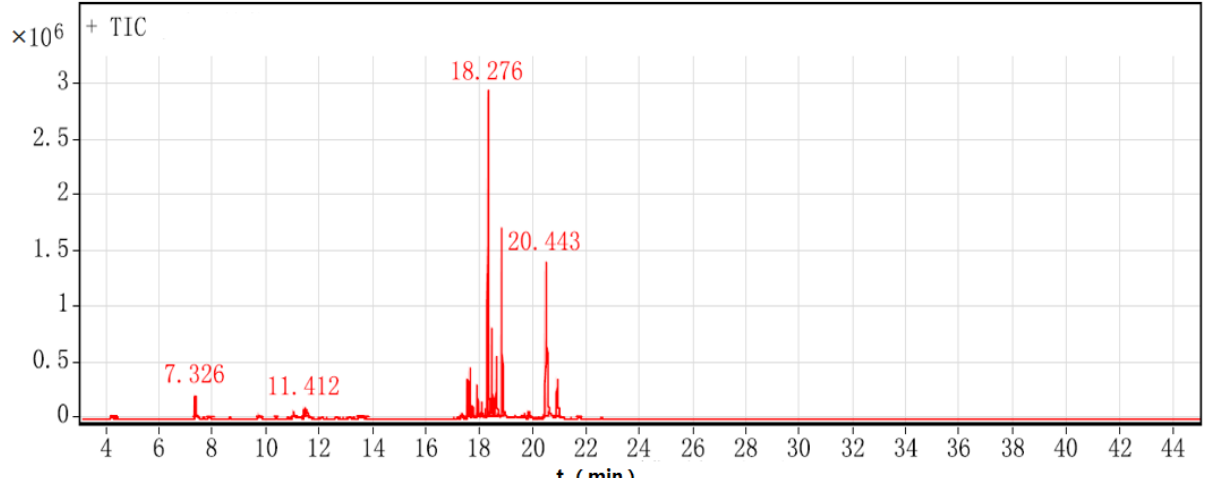
Figure 3. GC-MS total ion chromatogram of turmeric.